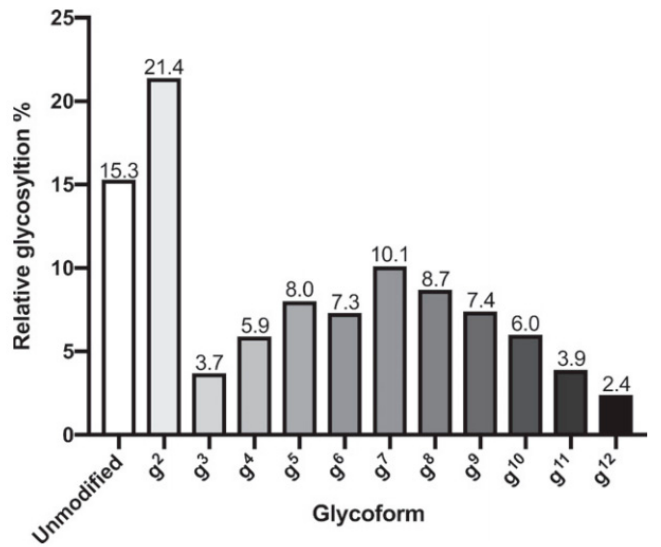
Figure 3. Quantification of the relative abundance of each K2 glycoform in K2-EPA. From Feldman et al. Ref. [53].